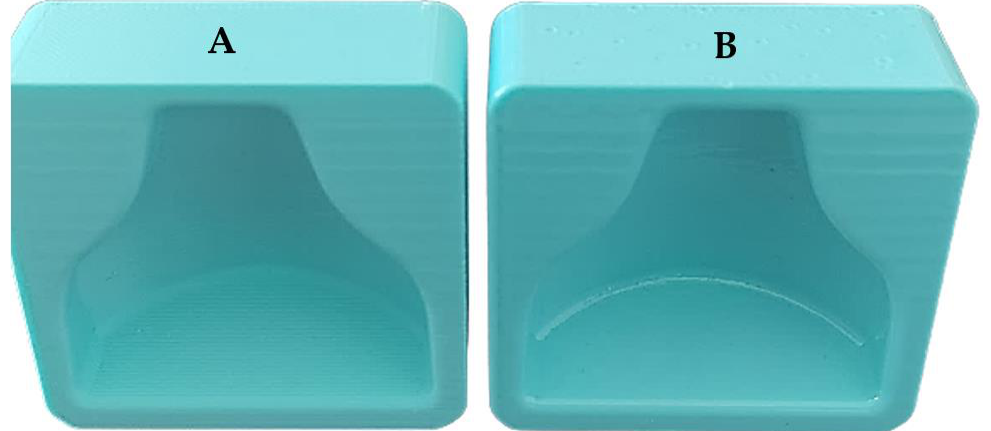
Figure 6. ( A ) Mold immediately after printing; ( B ) mold after smoothing treatment. On the top of the ( B ) mold are small circular spots; these are due to the support surface during smoothing and the rotation of 180 degrees. In the lower part